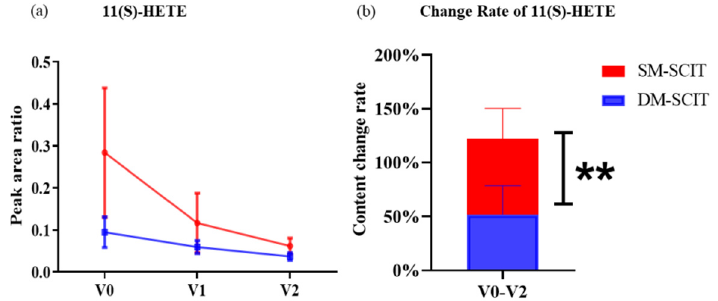
Figure 5. Analysis of the change degree of metabolic components. ( a ) Comparison of the concentra- tions of 11(S)-HETE between DM-SCIT and SM-SCIT groups from the pre-treatment stage (V0) to the first stage of the maintenance phase (V2). The results were expressed as mean ± SEM. ( b ) Com- parison of the change rate of 11(S)-HETE concentrations between DM-SCIT and SM-SCIT groups at V0 and V2. Blue, DM-SCIT group; red, SM-SCIT group. **, p < 0.01. The results were expressed as mean ± SD (standard deviation).